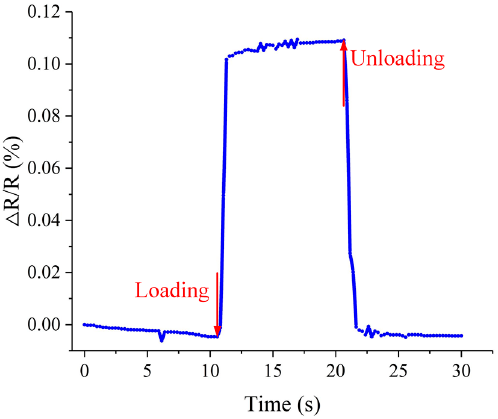
Figure 15. The dynamic response of the force sensor to a force pulse.